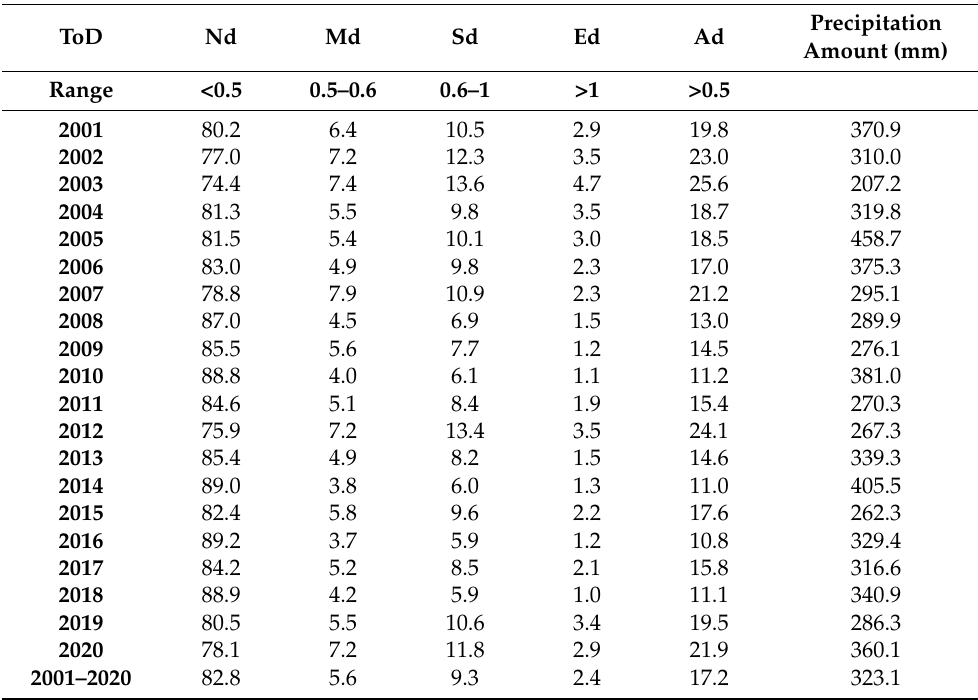
Table 5. Relative frequency (%) of NDDI drought classes between 2001 and 2020 (ToD—Type of drought, Nd—No drought, Md—Moderate drought, Sd—Severe drought, Ed—Extreme drought and Ad—All types of drought) and the precipitation amount (mm) accumulated between 5 of March and 13 of September. Normal Difference Drought Index (NDDI)